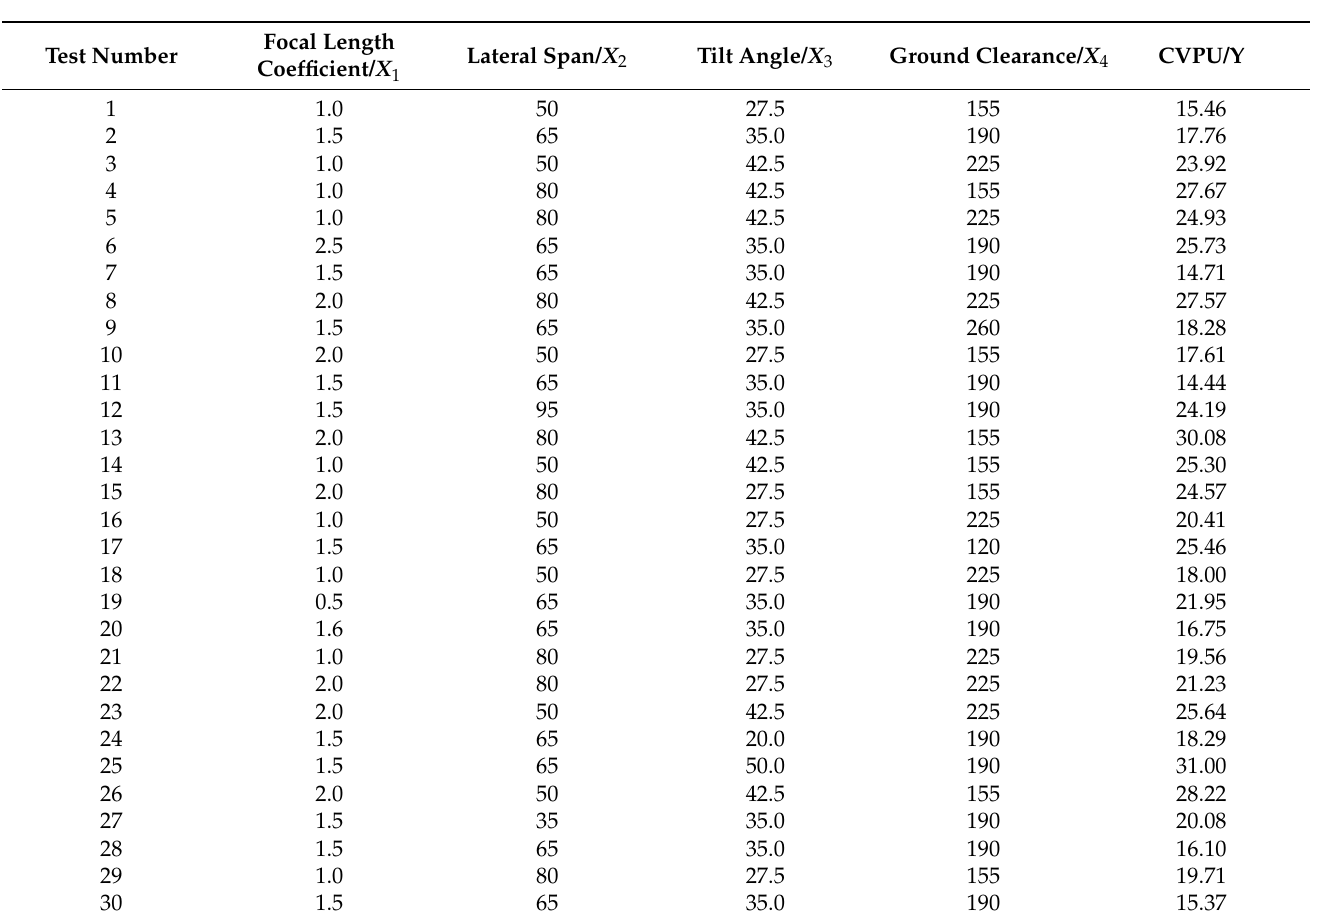
Table 3. Test factors and levels of virtual test.